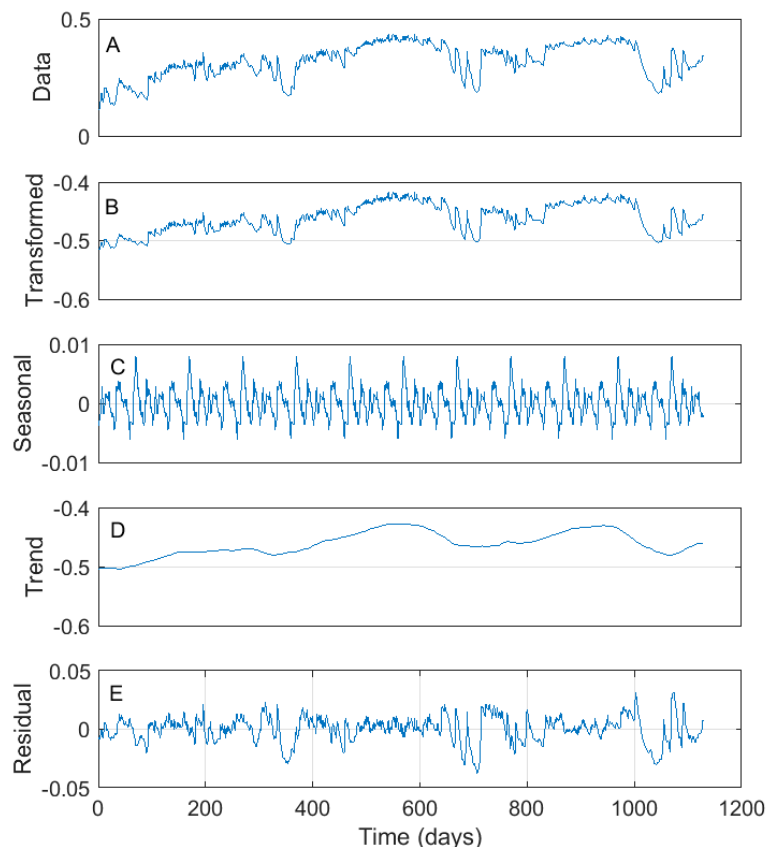
Figure 4. Soil moisture data transformation and decomposition prior to modelling. ( A ) Observed data. ( B ) Box–cox transformed data. ( C ) Seasonal component. ( D ) Trend component. ( E ) Residual component.